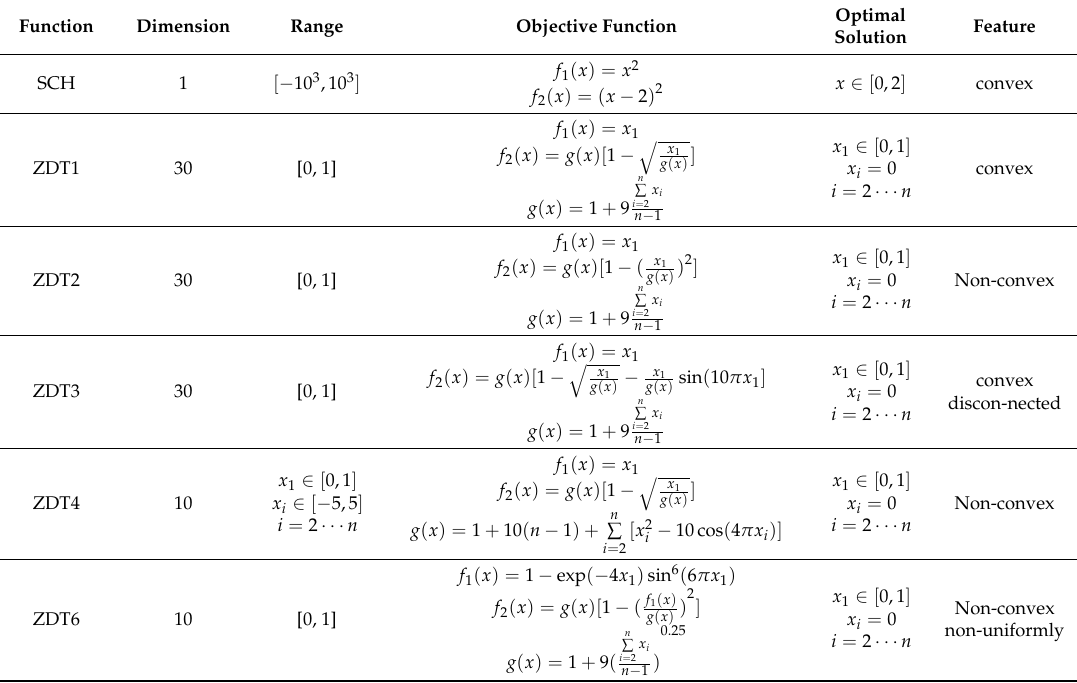
Table 1. six test function for multi-objective optimization